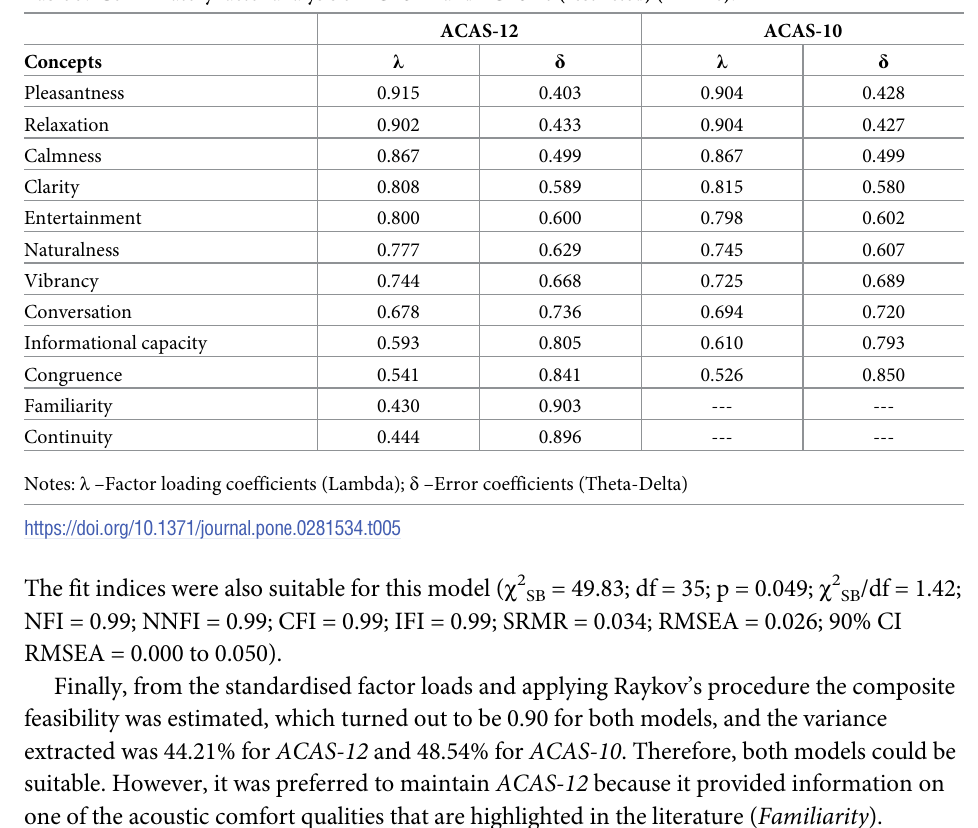
Table 5. Confirmatory factor analysis of ACAS-12 and ACAS-10 (restricted) (n =